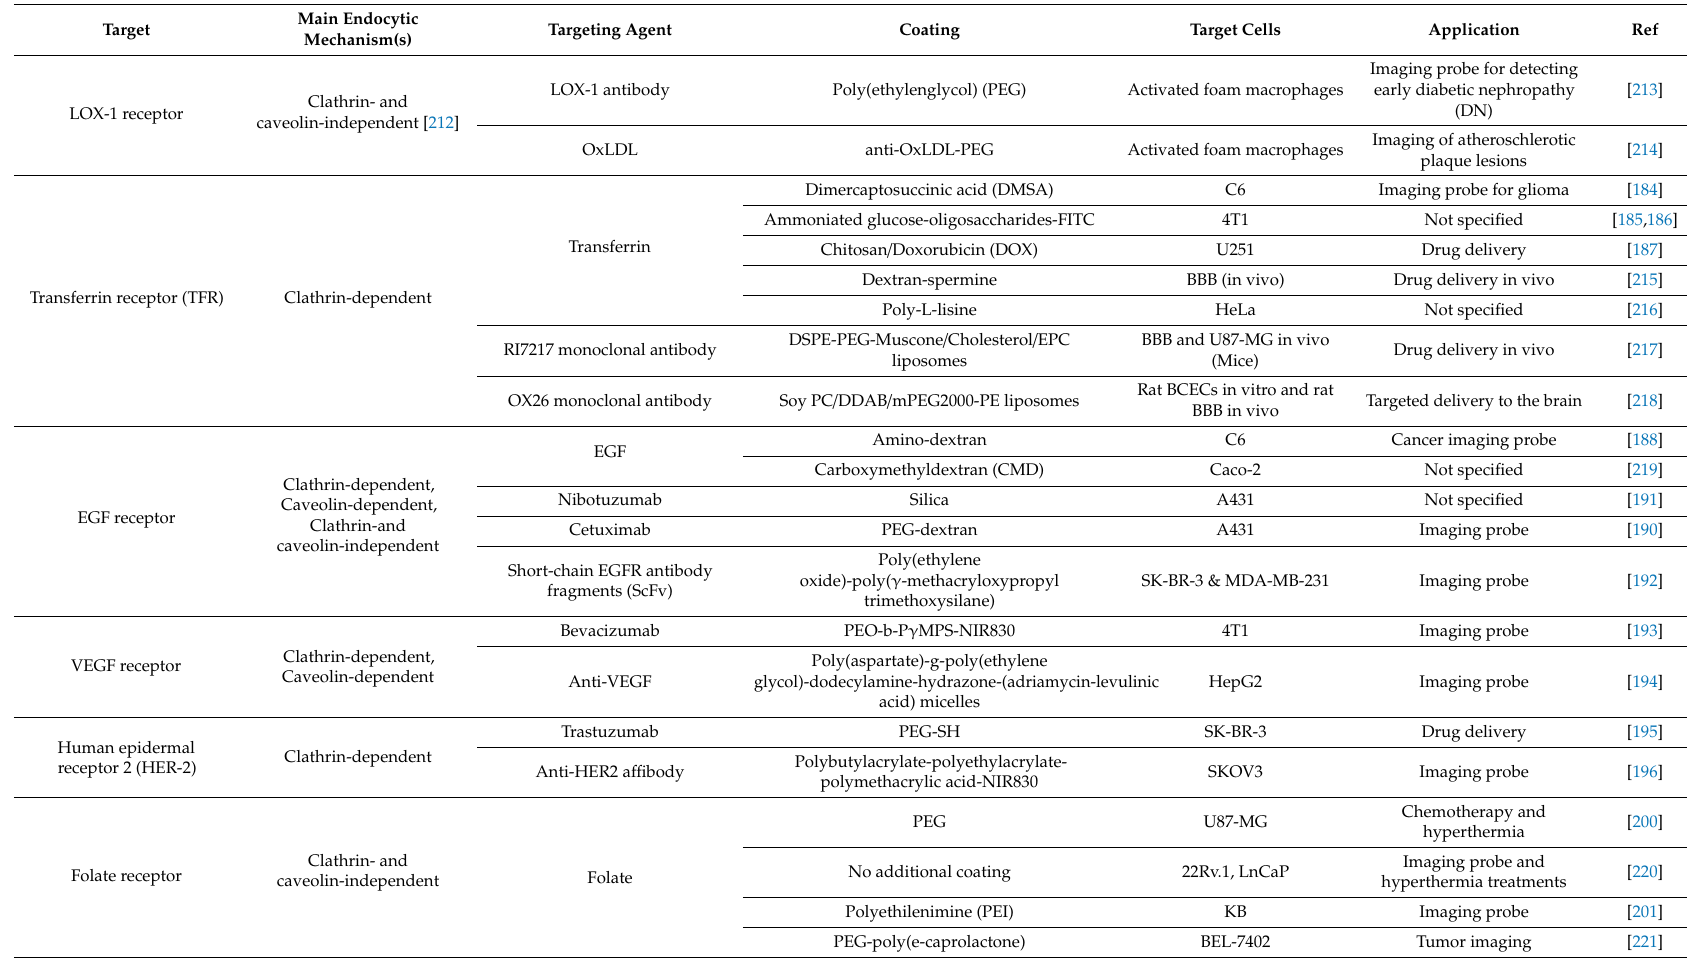
Table 2. IONs decorated with targeting agents for their internalization through receptor-mediated endocytosis in their target